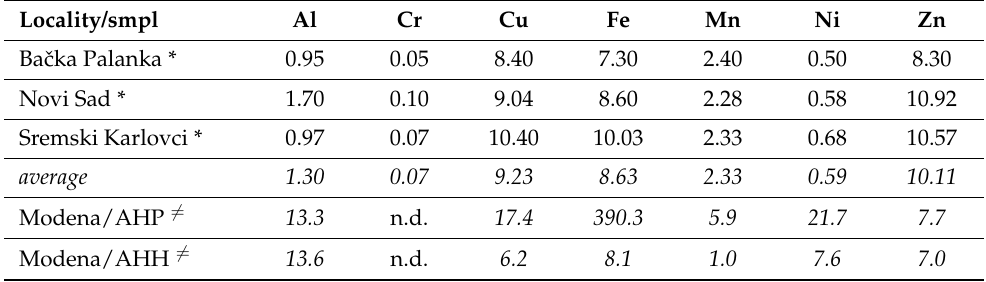
Table 12. Heavy metals concentration ( µ g/g of fresh material) in seed samples of different origins. Locality/smpl Al Cr Cu Fe Mn Ni